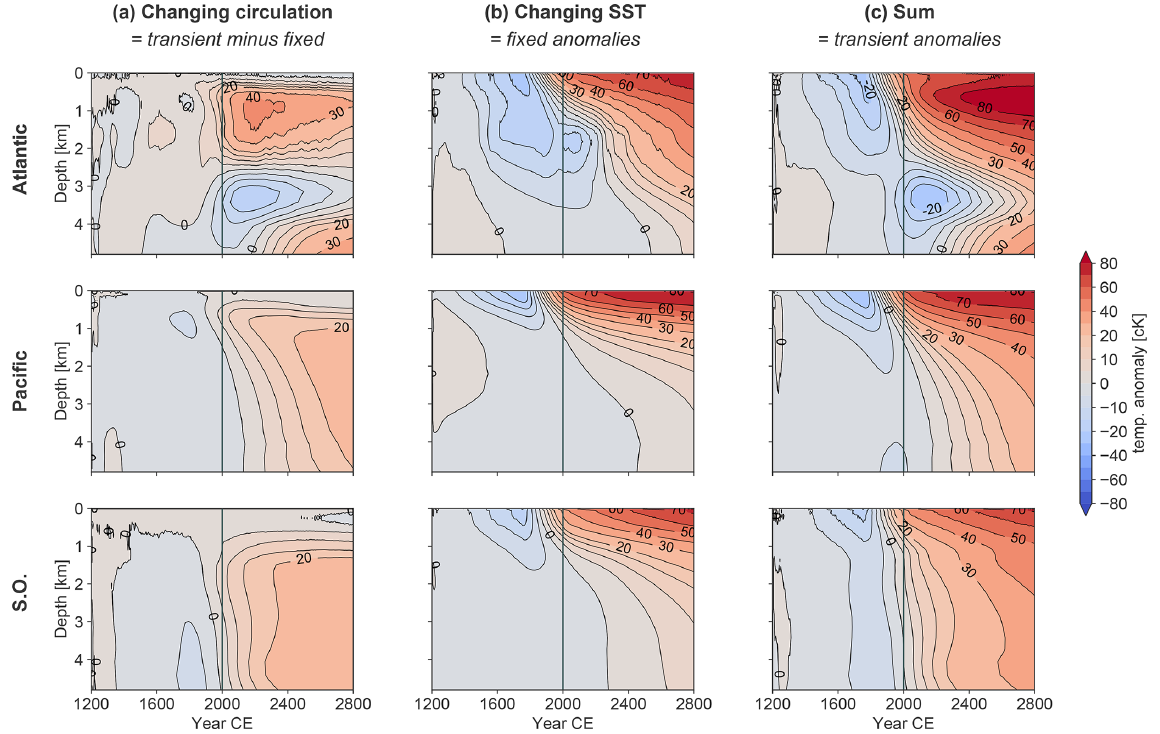
Figure A2. Hovmöller diagrams of temperature anomalies over depth, decomposed into the effects of (a) changing circulation and (b) chang- ing SST with (c) the total. (a–c) Same as Fig. 4a minus b, Fig. 4b and a (see main text). Values are in centi-Kelvin (1cK = 10 − 2 K) and are basin averages of the Atlantic or Pacific (35 ◦ S–70 ◦ N) or the Southern Ocean ( < 35 ◦ S). Colour levels increase in steps of 5cK from − 20 to 20cK and in steps of 10cK